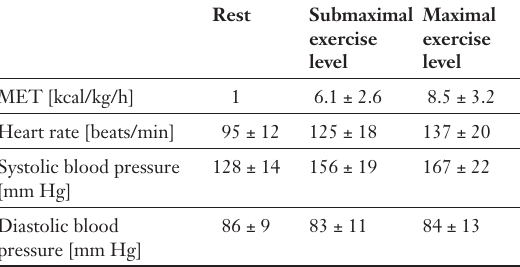
Haemodynamic parameters. TEF: ejection fraction; LVEDP: left ventricu- lar enddiastolic pres- sure; PVR: pulmonary vascular resistance; CO: cardiac output.